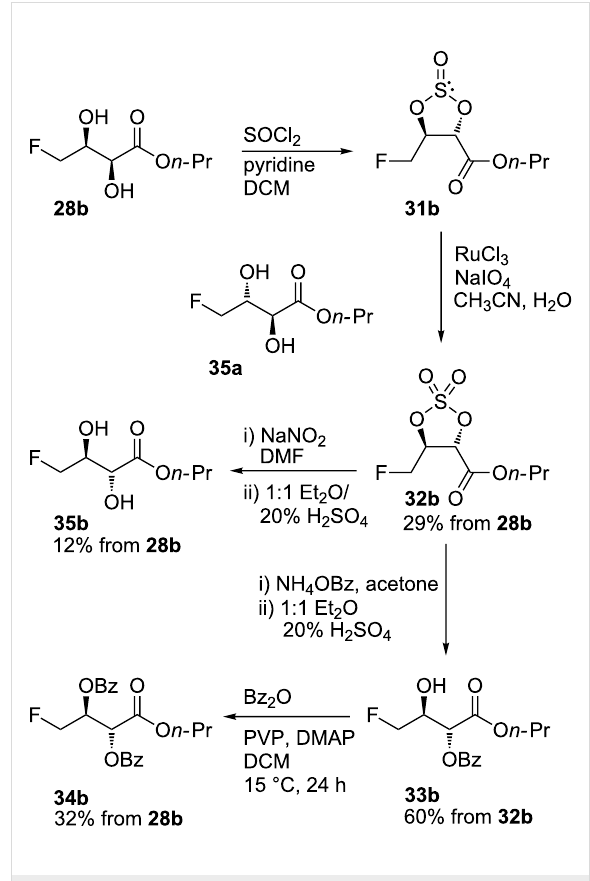
Scheme 7: Applying cyclic sulfate methodology to gain access to anti - diastereoisomers (transformations were developed from racemic diol 28c , but are shown for diol 28b